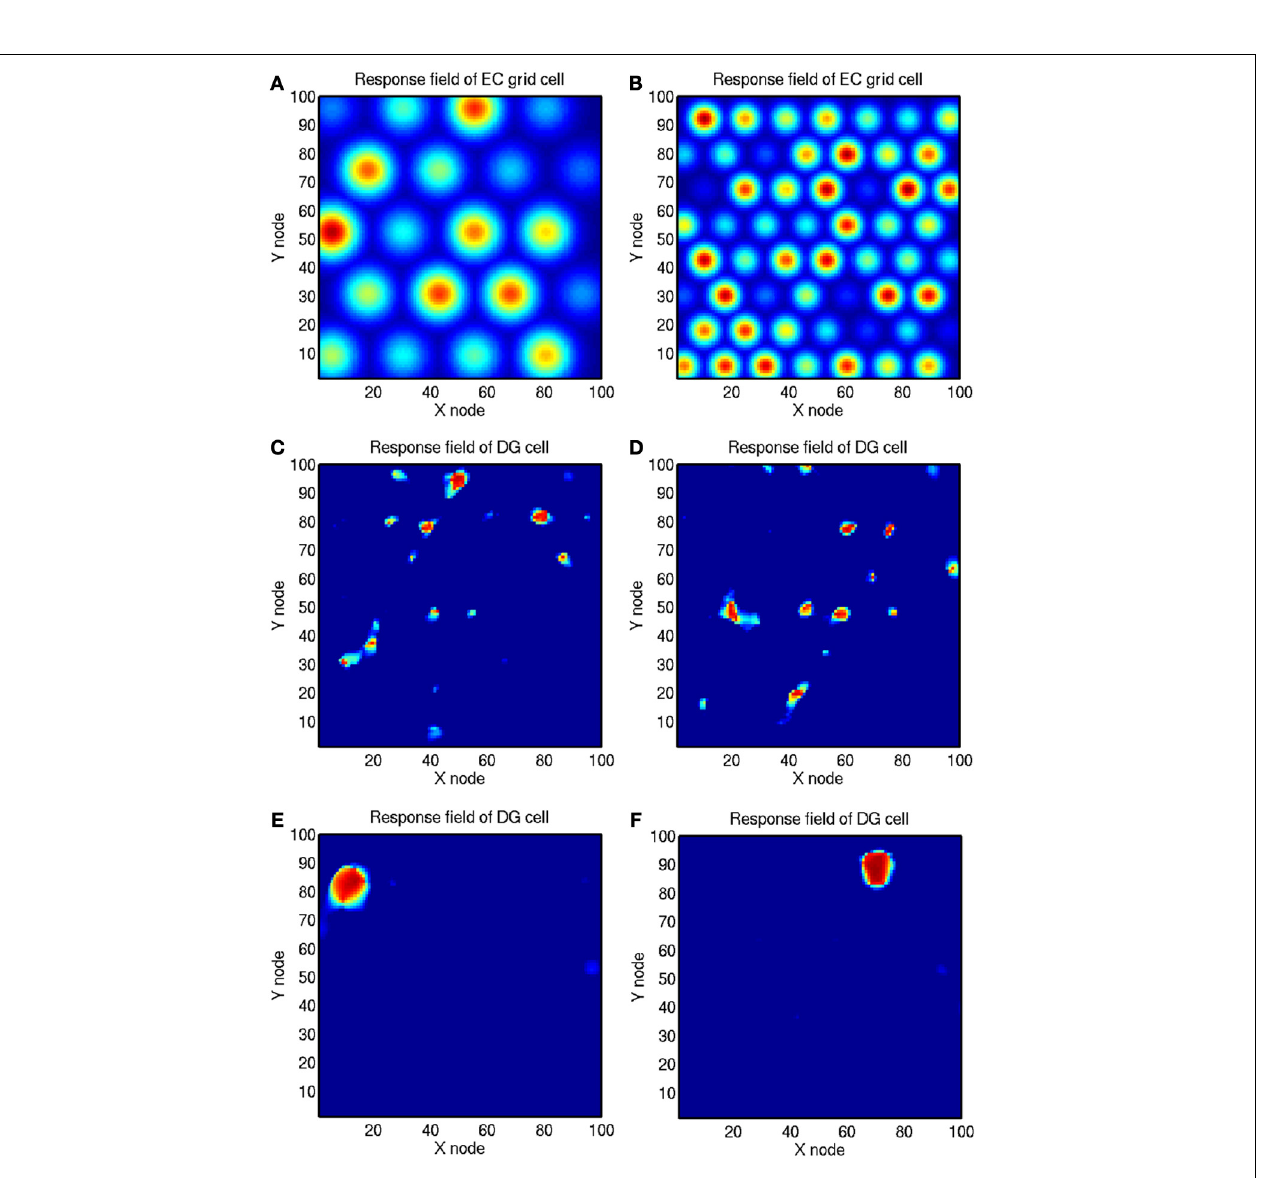
Firing rate profiles of two dentate gyrus (DG) cells with no training using competitive learning. (E and F) Firing rate profiles of two dentate gyrus (DG) cells trained using competitive learning. (After Rolls et al.,